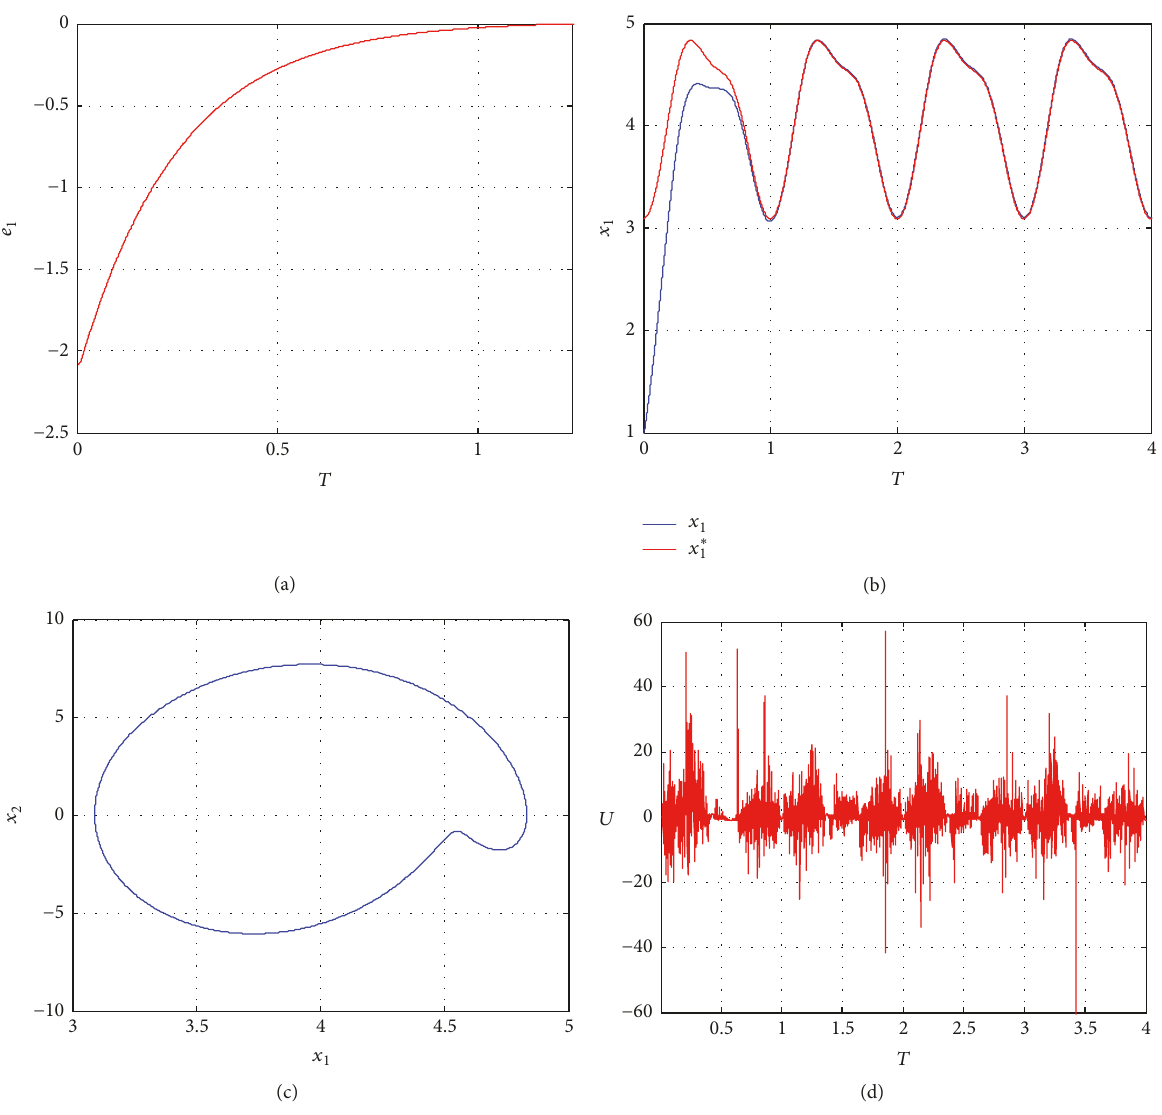
Figure 9: (a) Desired trajectory error ( 𝑒 1 ). (b) Displacement ( 𝑥 ∗ 1 is the desired trajectory and 𝑥 1 is displacement with proposed control (20)). (c) Phase portrait for controlled systems. (d) Control